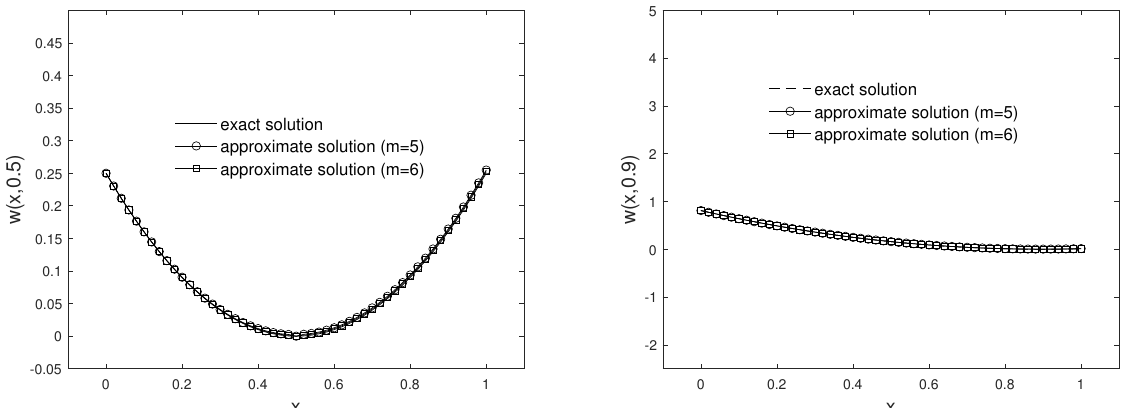
Figure 9. Plot of exact and approximate solutions at time t = 0.5 and t = 0.9 taking θ = 1, r = 5, J = 2 and δ t = ( 0.1 ) /2 m for Example 2.